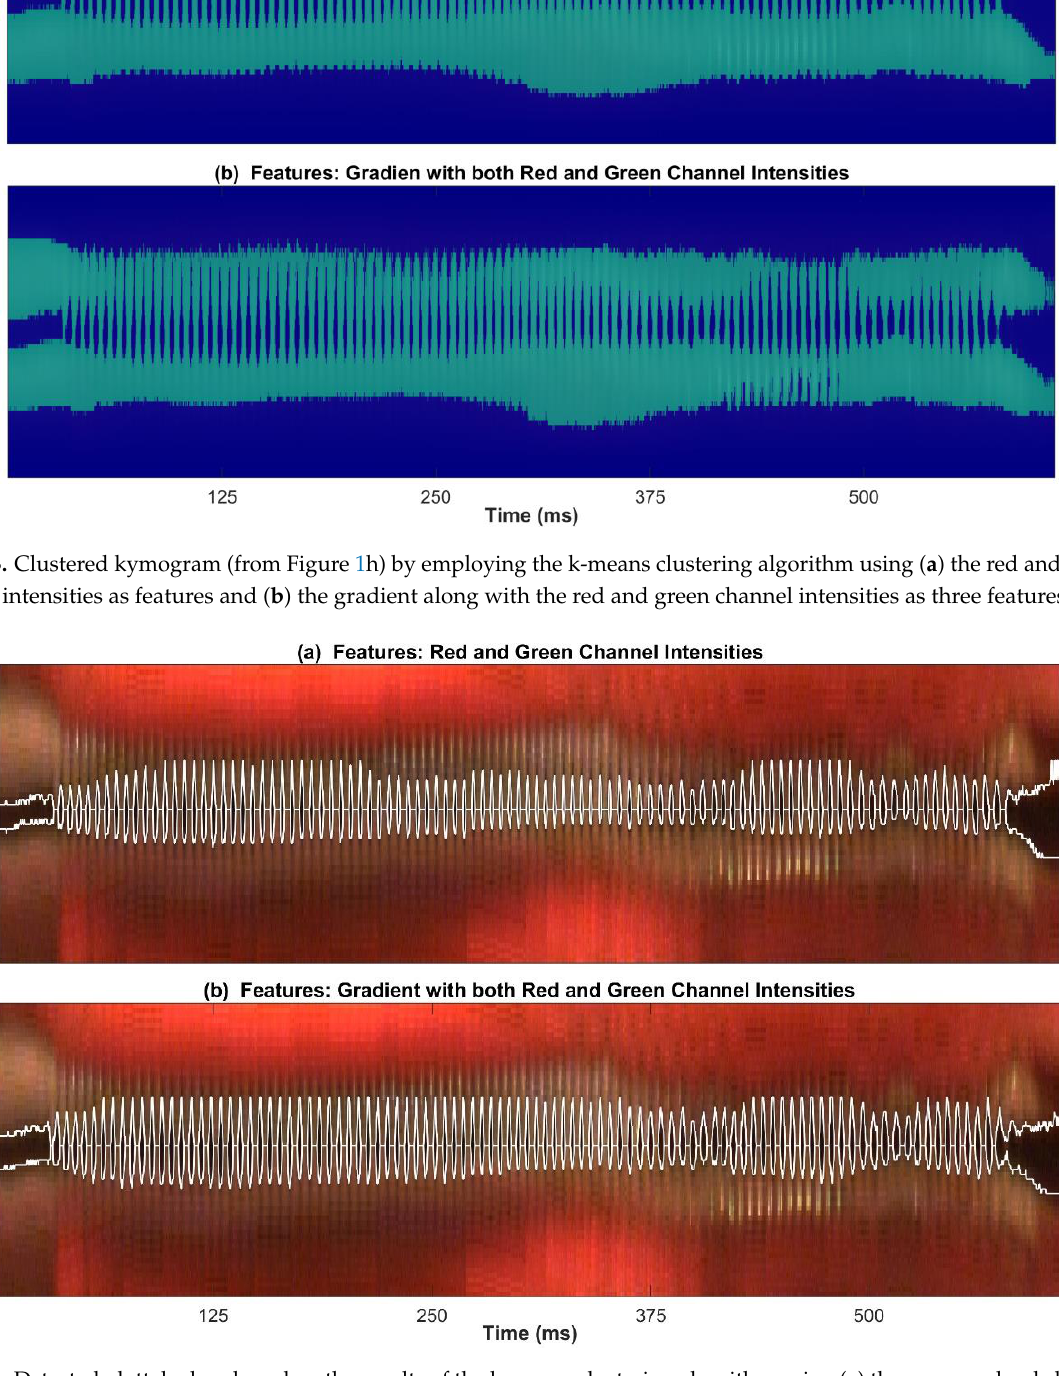
Figure 4. Detected glottal edges based on the results of the k-means clustering algorithm using ( a ) the green and red channel intensities as features and ( b ) using the gradient along with both red and green channel intensities as three features.